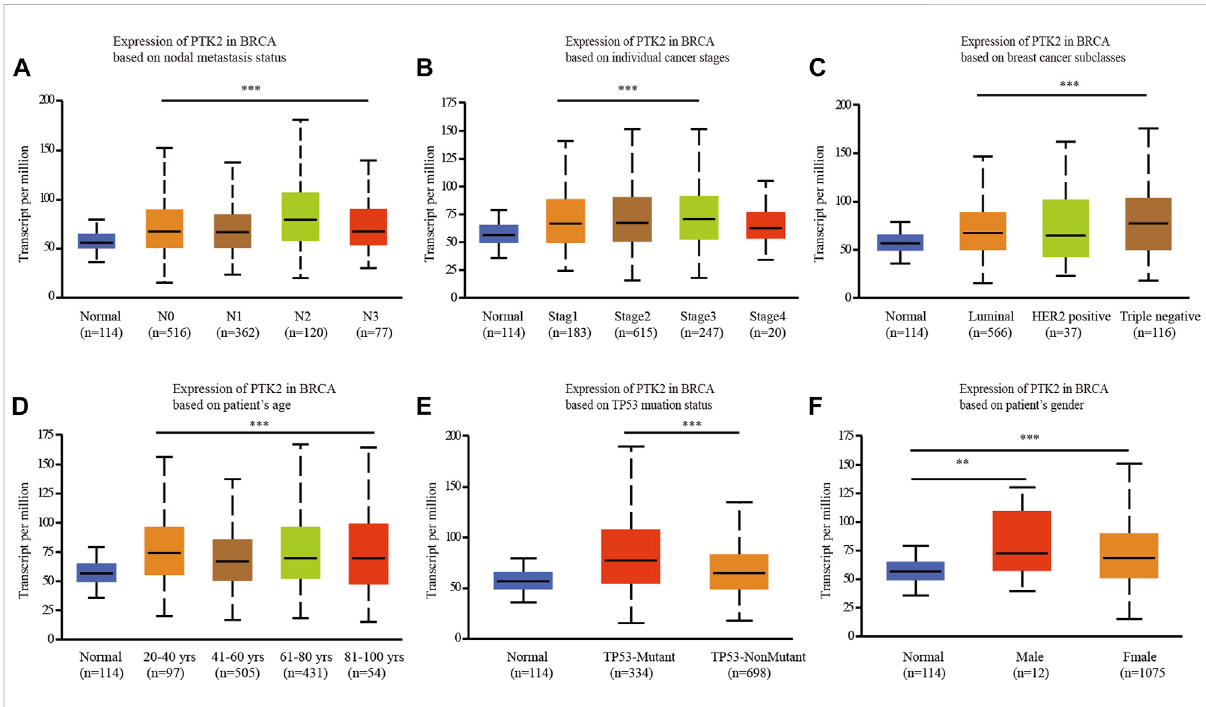
FIGURE 2 BoxplotevaluatingPTK2expressionofpatientswithbreastcanceraccordingtodifferentclinicalcharacteristicsusingtheUALCANdatabase. (A) Nodal metastasis, (B) tumor stage, (C) breast cancer subclasses, (D) age, (E) T53 mutation status, and (F)